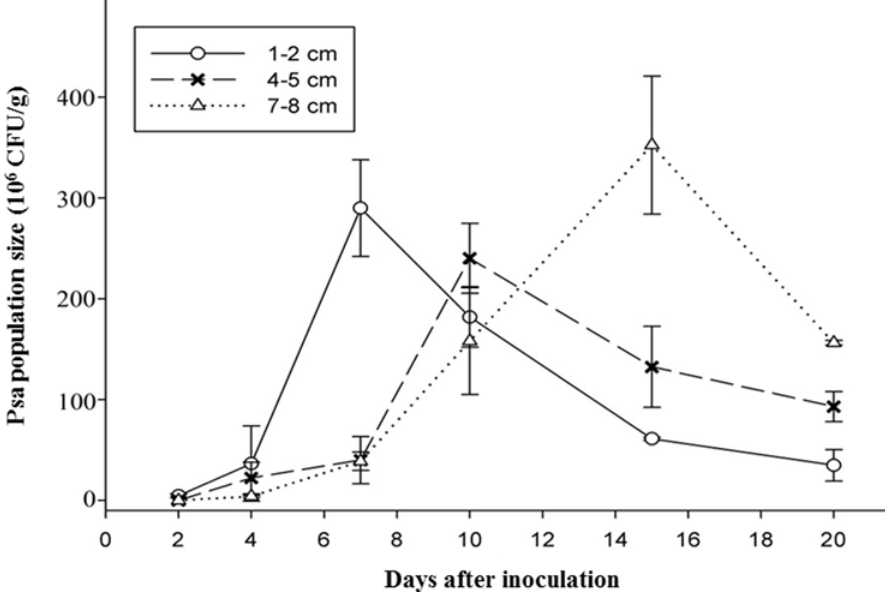
Fig 2. Quantification of the GFPuv-labeled Psa in kiwifruit twigs using the plating method (in BPA plates supplemented with 50 μ g (cid:1) mL − 1 KAN) following cutting